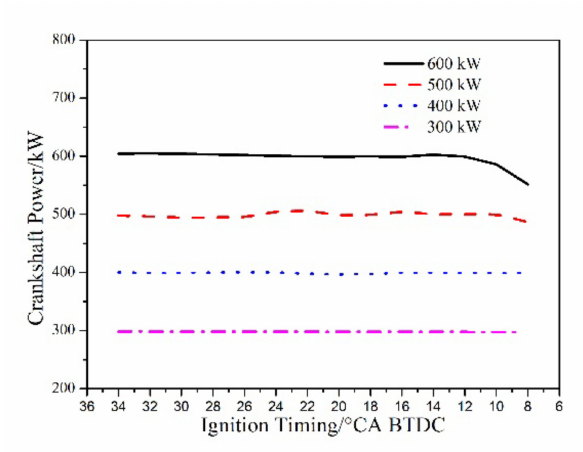
Figure 17. Power performance during constant power operation.